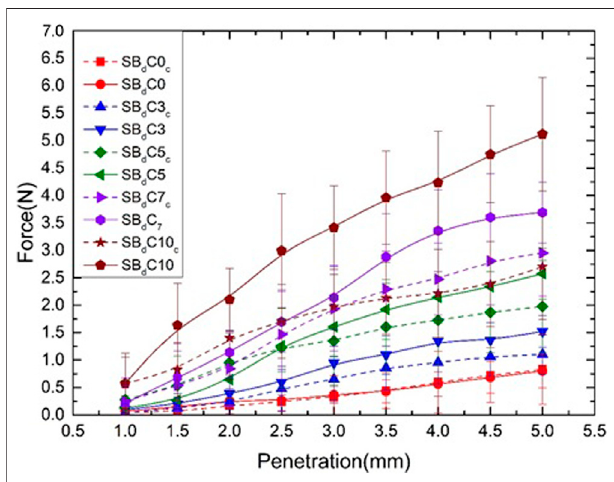
FIGURE 12 | Needle penetration of Petri-dish samples treated with in- situ biopolymer.